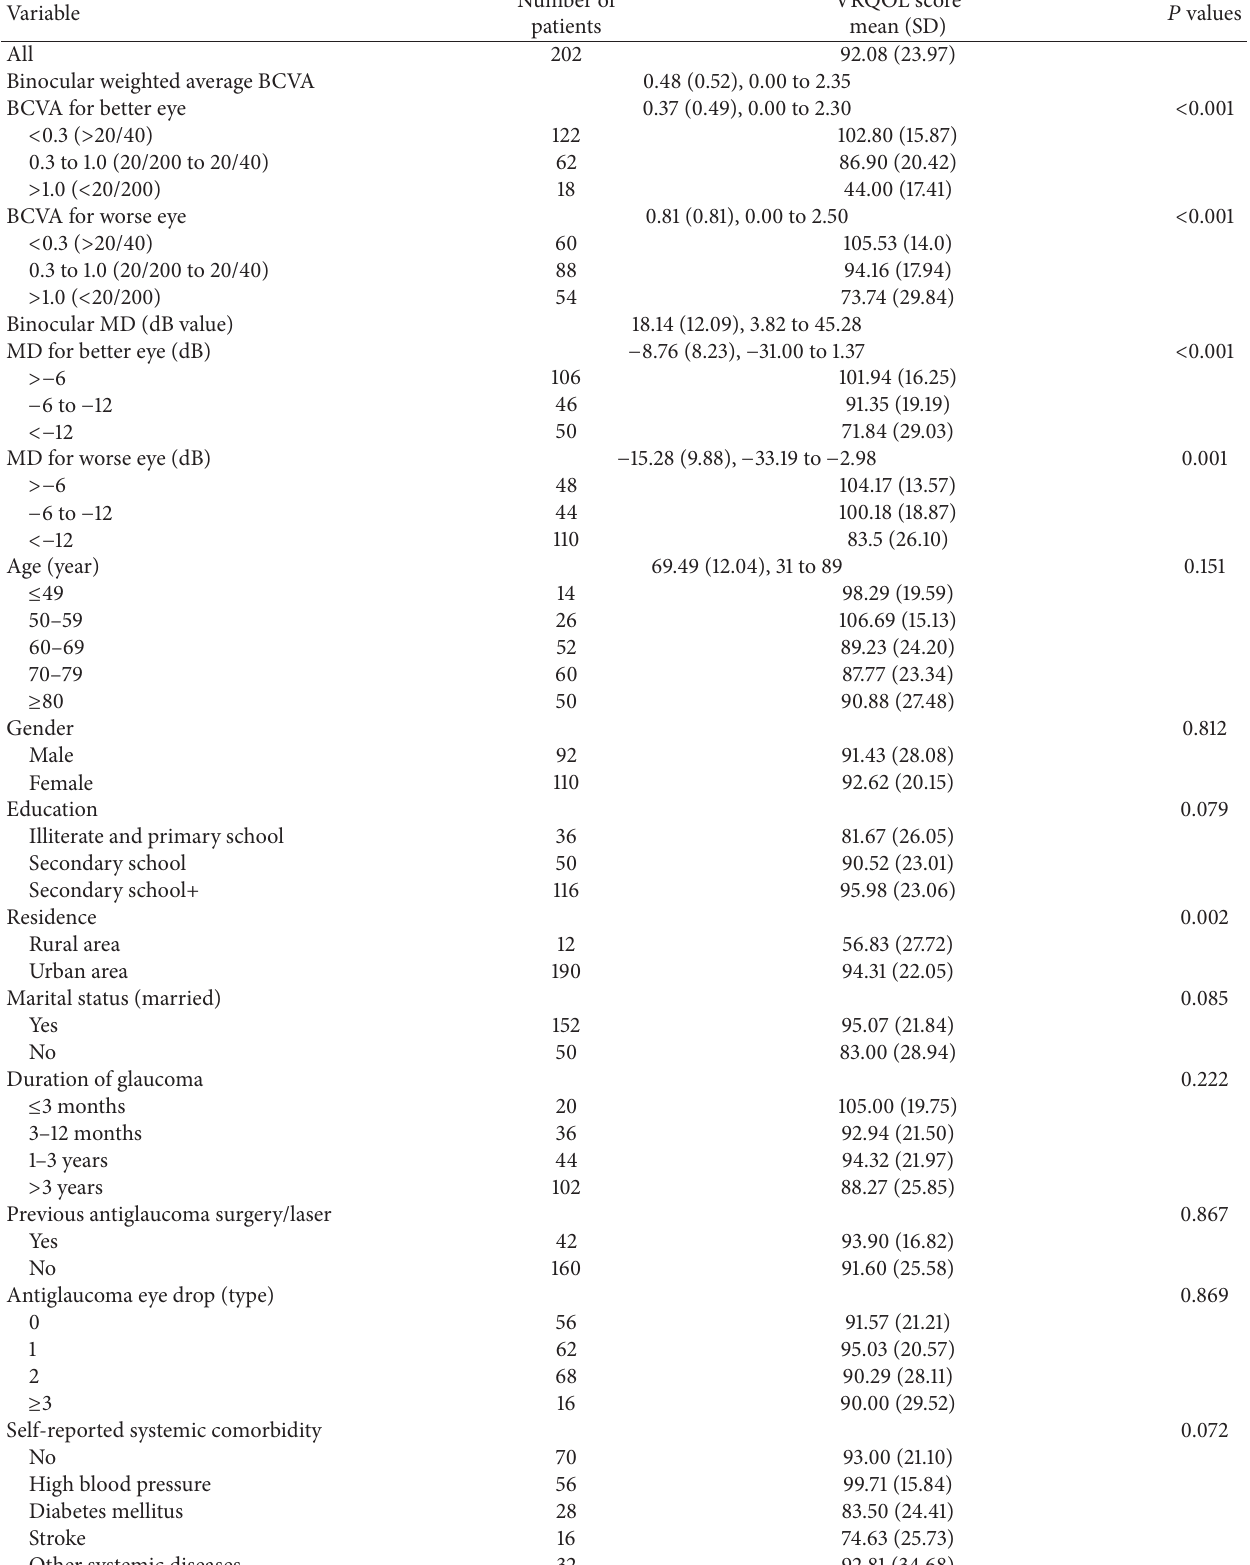
Table 1: Patient’s demographic characteristics and clinical